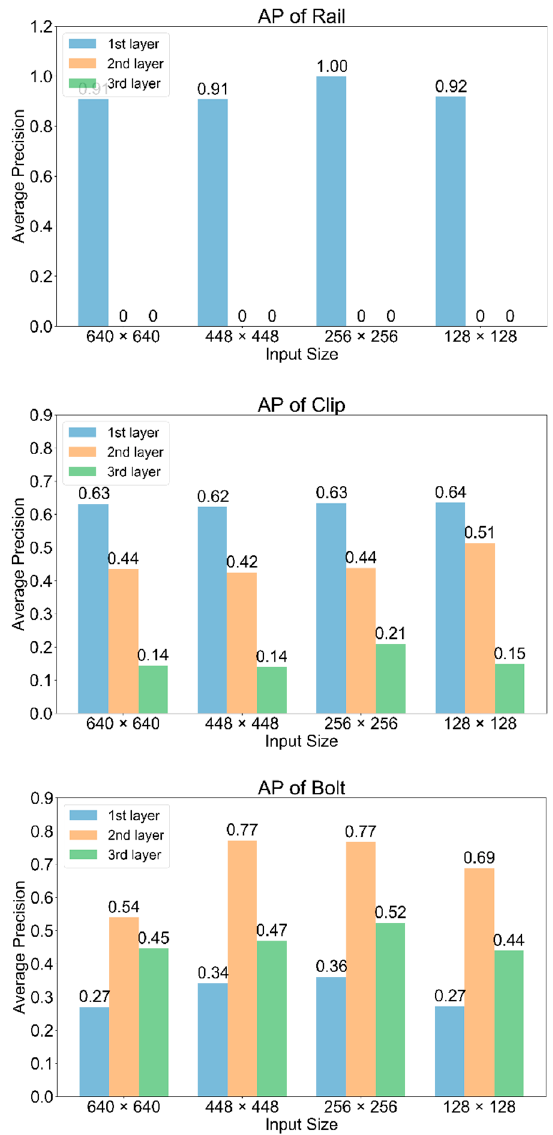
Figure 9. AP values of three classes on different layers with various input sizes.